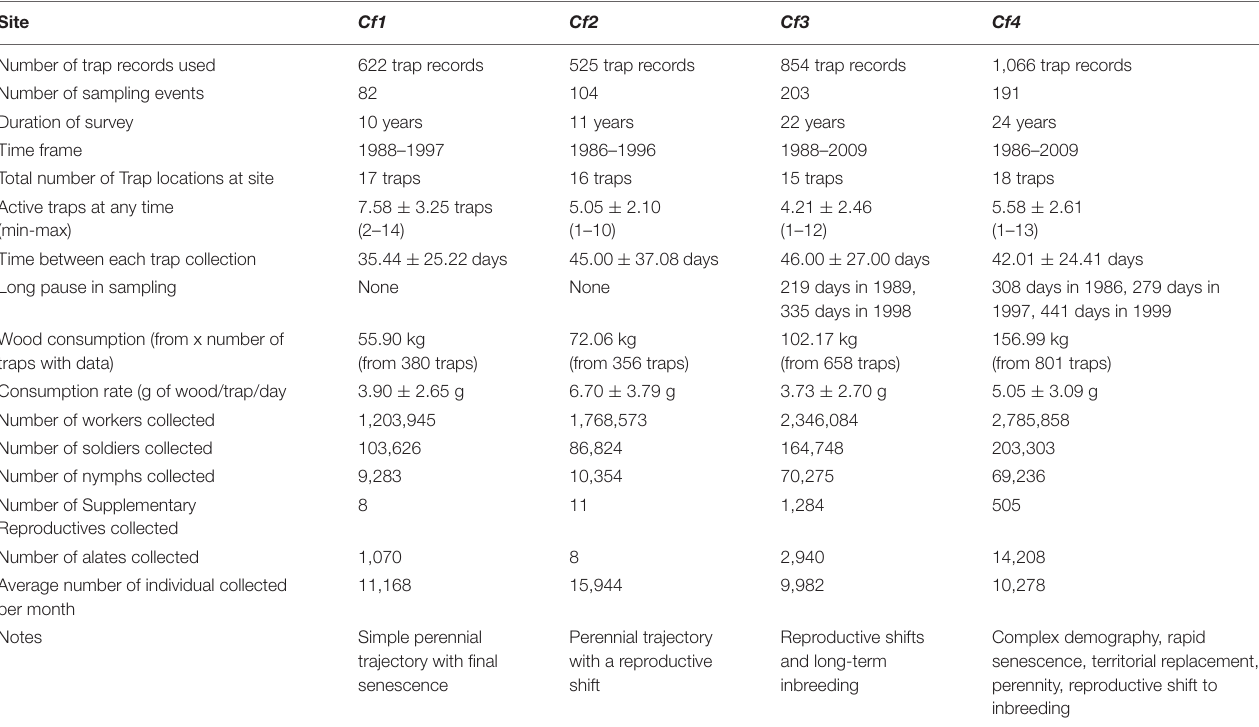
TABLE 1 | Summary of the trap sampling